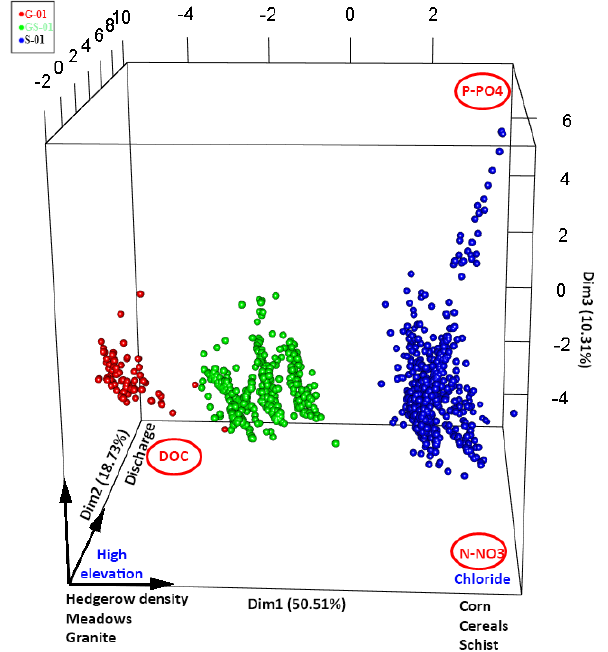
Figure 4. Principle components analysis of the major sources of variability in water chemistry. Together, the first three axes explain 80% of the total variability of the data. Principal and supplemen- tary variables are indicated respectively in black and blue. Red cir- Figure 5. Discharge and carbon and nutrient concentrations during cles indicate the poles of carbon, nitrogen, and phosphorus associ- 5 contrasting hydrological years. Boxplots of (a) specific discharge, ated with cereals and corn for N-NO − , high discharge on granite 3 (b) dissolved organic carbon, (c) nitrate, (d) ammonium, (e) phos- bedrock for DOC, and both discharge and agricultural land use for phate, and (f) dissolved silica for the catchments G-01 (red box), P-PO 3 − . PCA scores are indicated in Table S3. 4 GS-01 (green box), and S-01 (blue box). Boxplots represent me- dian, quartiles, minimum, and maximum within 1.5 times the in- terquartile range and outliers beyond 1.5 interquartile